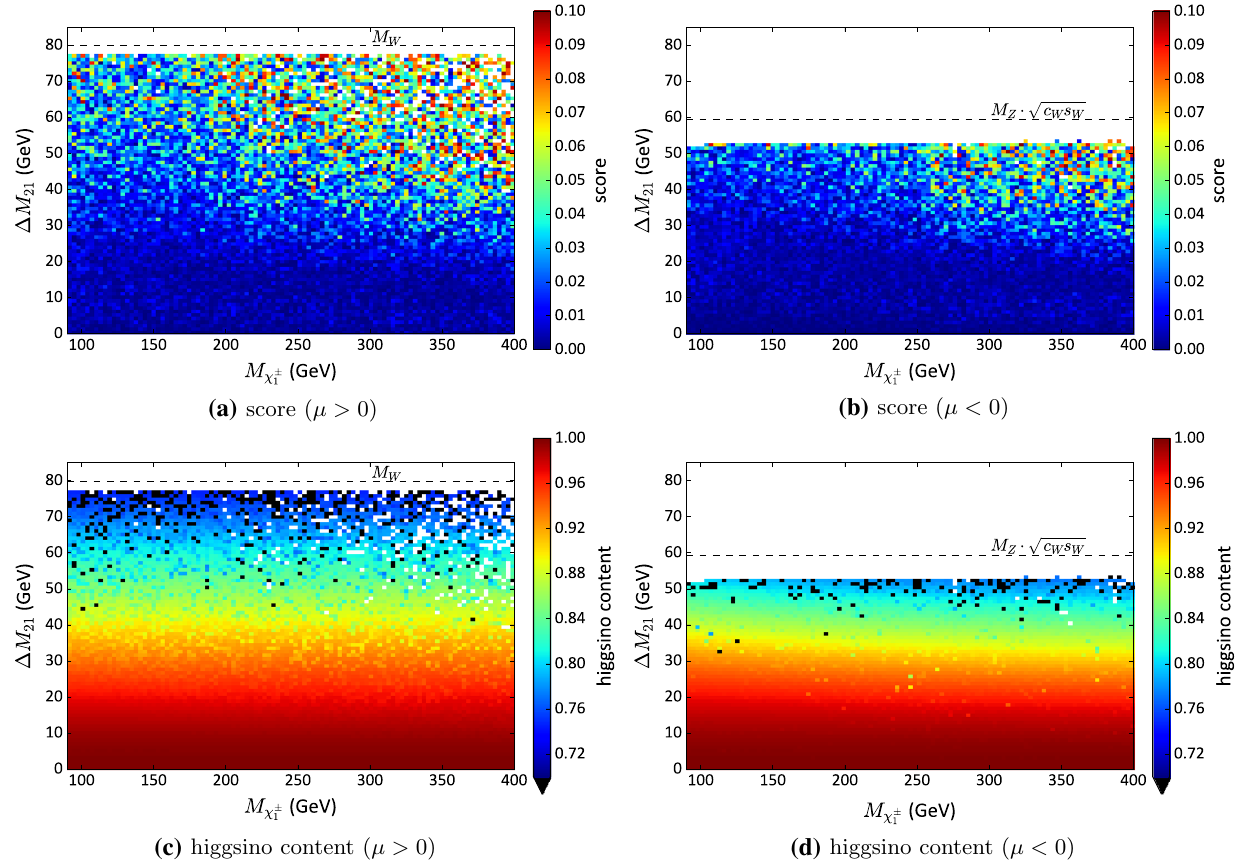
Fig. 3 Scores and average higgsino contents of χ 0 mass splitting Δ M 21 . The dashed lines indicate that the latter are always smaller than O ( M W ) (remember that M W = M Z c W )